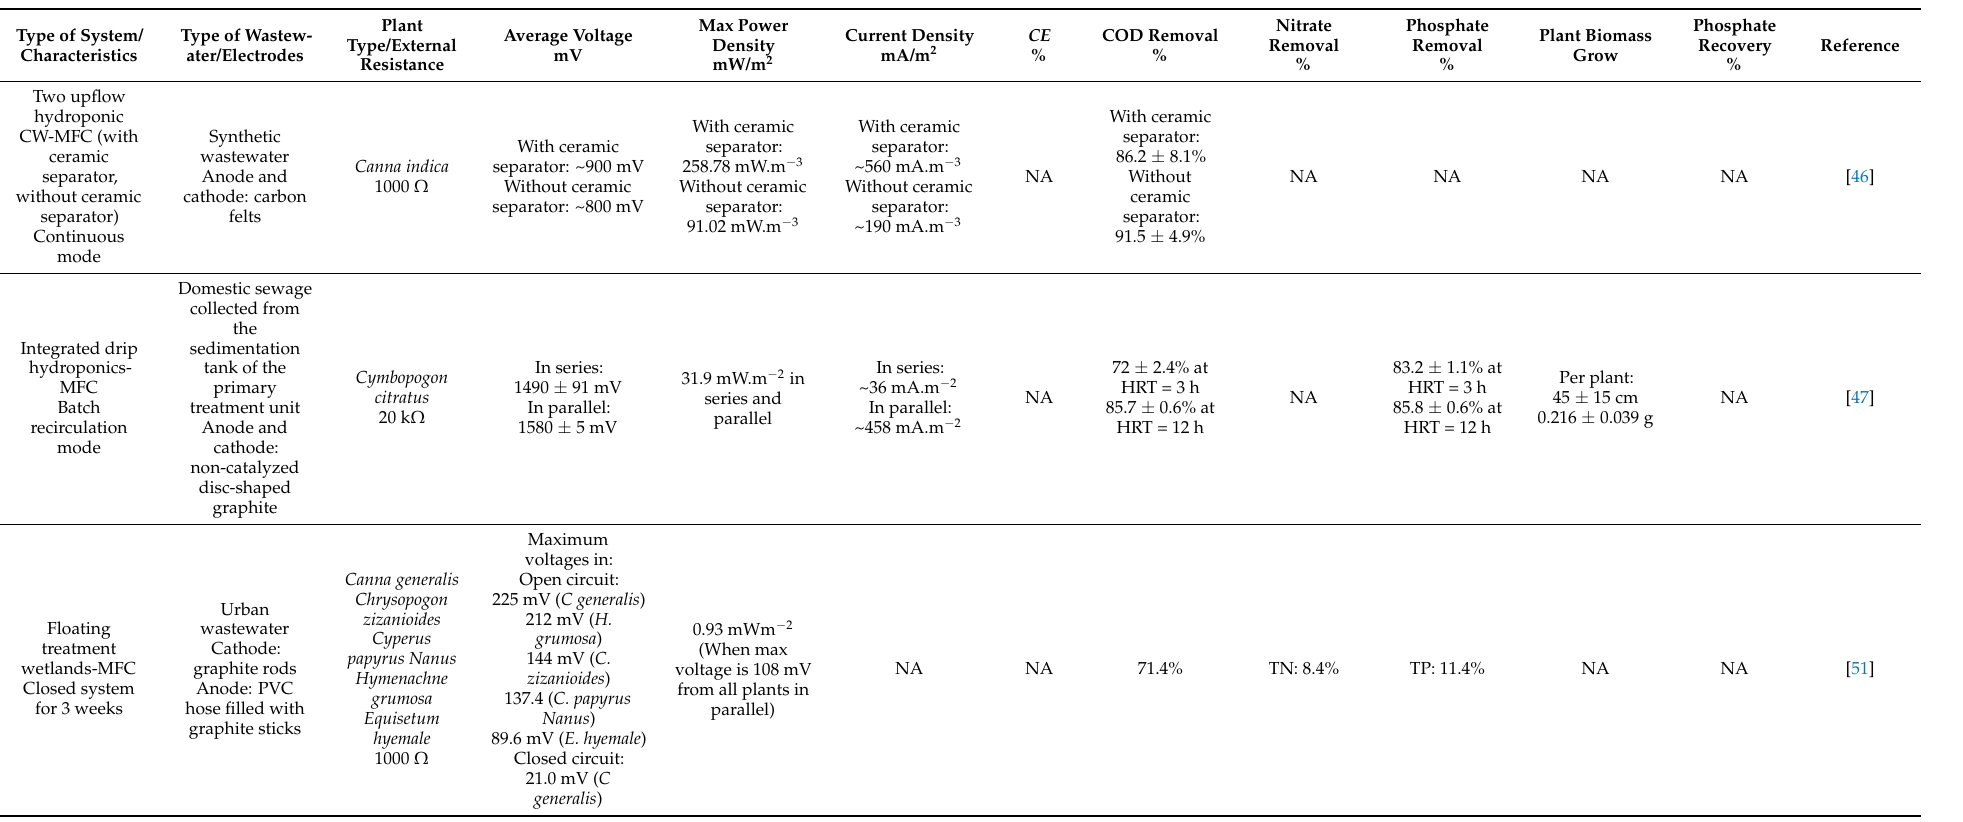
Table 1. Summary of different integrated systems for wastewater treatment, nutrient removal, and resource